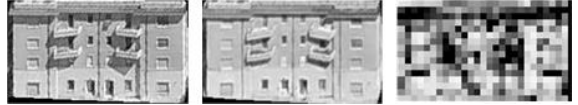
Figure 14. Pre-event rectified image patches and corresponding correlation coefficient.